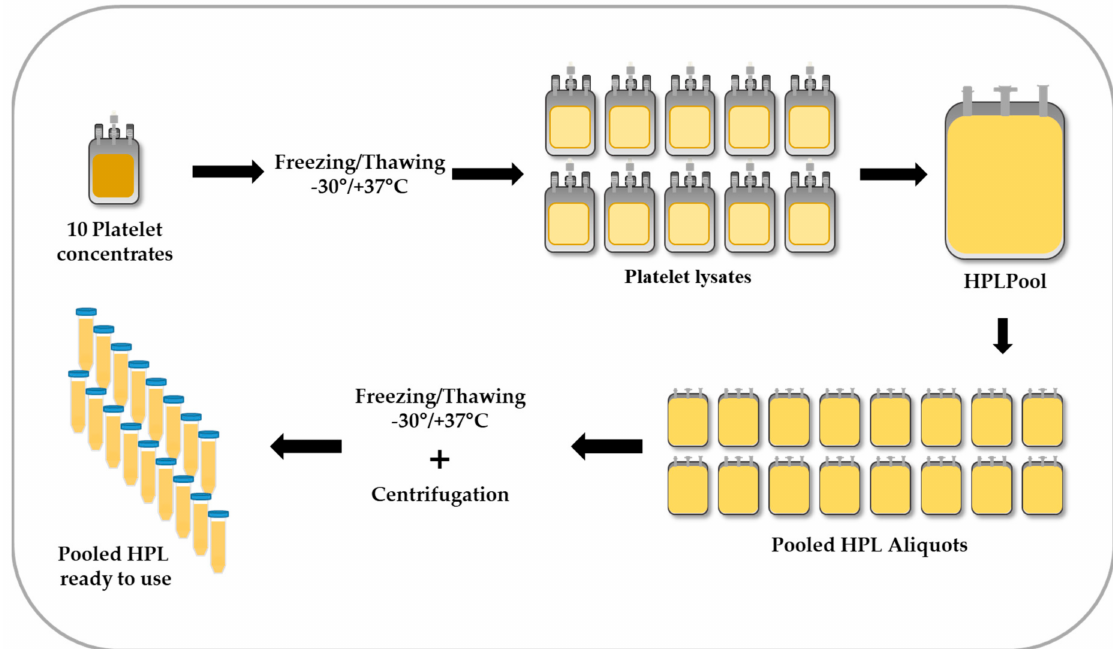
Figure 1. Preparation of pooled human platelet lysate (HPL). Fresh or expired platelet concentrates are exposed to freezing/thawing for platelet lysis. Ten units of platelet lysates are pooled in one bag and further portioned. After a second freeze/thaw step, the bags are centrifuged to deplete the platelet fragments. Final vials of pooled HPL are stored at least at − 30 ◦ C until